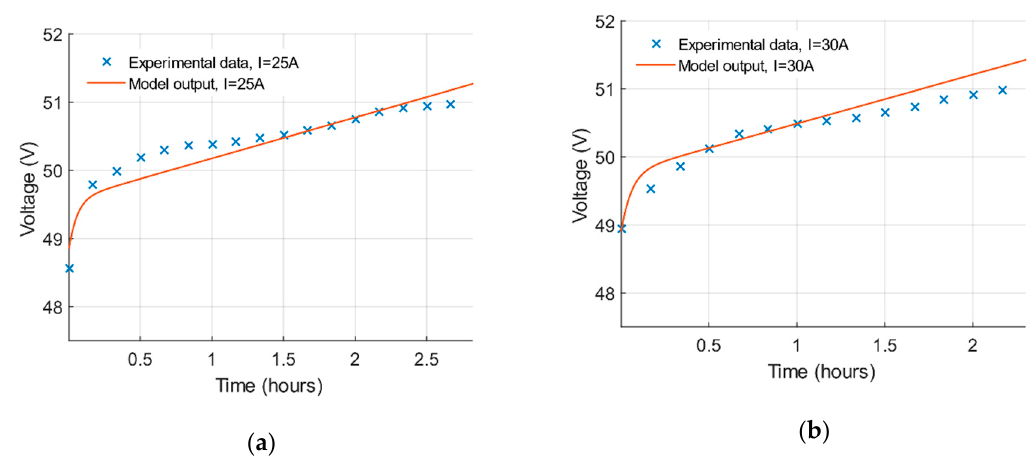
Figure 4. Data fitting curves: ( a ) For I = 15 A; ( b ) For I = 20 A.